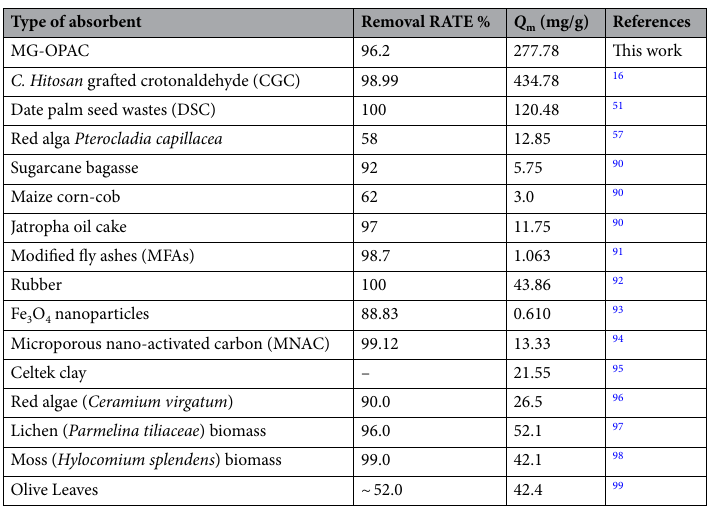
Table 5. Assessment of various adsorbents and the MG-OPAC for the removal of Cr 6+